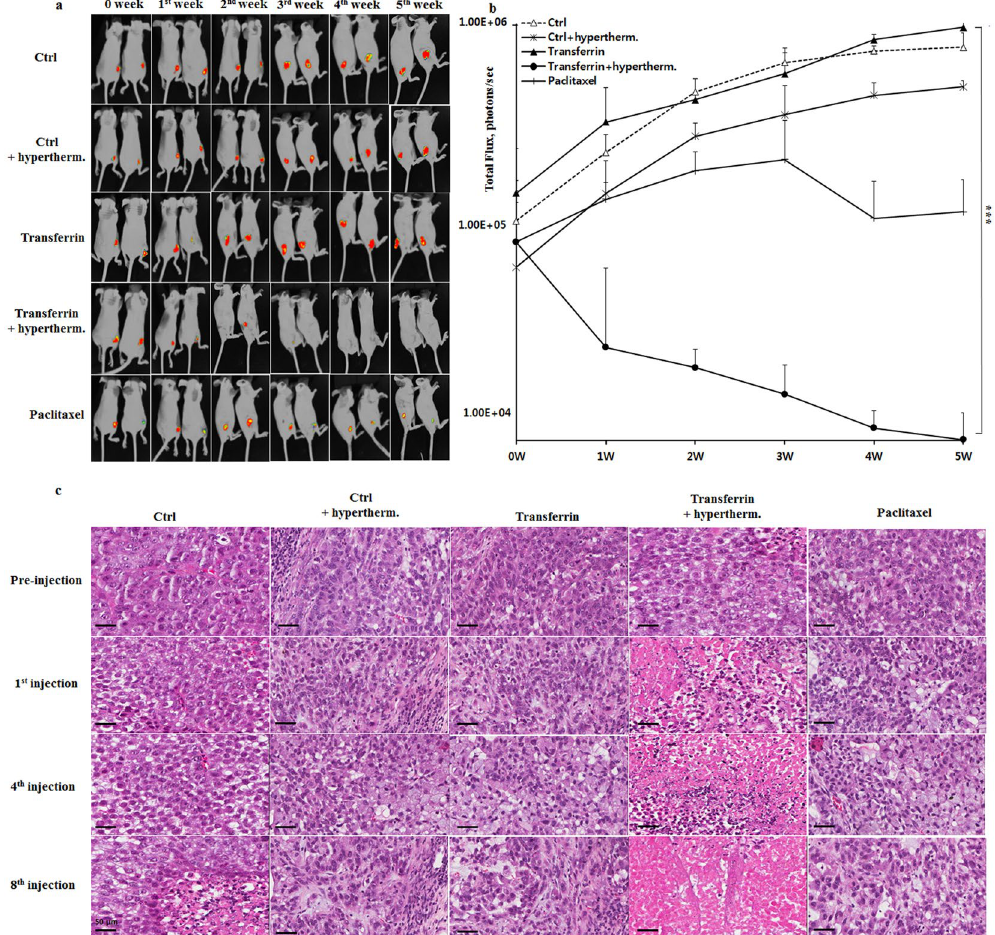
Figure 6. The oncotherapeutic efficacy of transferrin as a thermosensitizer in a local 13.56 MHz radiofrequency hyperthermia. ( a ) The in vivo evaluation results of oncotherapeutic efficacy of transferrin as a thermosensitizer in the local 13.56 MHz radiofrequency hyperthermia in a tumor-xenografted mouse model. Tumor- xenografted mice received intravenous injections of apotransferrin or transferrin followed by local 13.56 MHz radiofrequency hyperthermia every three days for 5 weeks, and efficacy was evaluated weekly. ( b ) The representative in vivo bioimage of the tumor-xenografted mice to evaluate the oncotherapeutic efficacy of transferrin as a thermosensitizer in 13.56 MHz radiofrequency hyperthermia. ( c ) The representative histological examination results of the cancer tissues of the tumor-xenografted mice after each different treatment. The abbreviation in this figure, Ctrl: control mice with apotransferrin injection, Ctrl + hyperthem.: control mice with apotransferrin injection followed by local treatment of 13.56 MHz radiofrequency hyperthermia, transferrin; mice with transferrin injection only, transferrin + hypertherm.: mice with transferrin injection as a thermosensitizer followed by local treatment of 13.56 MHz radiofrequency hyperthermia, paclitaxel: mice in which equivalent dose of paclitaxel was injected as a chemotherapeutic agent without radiofrequency hyperthermia treatment. The values represent the mean ± standard deviation ( n = 6). A paired Student’s t-test was used for the statistical analysis; *** p < 0.001. Scale bar, 50 µ